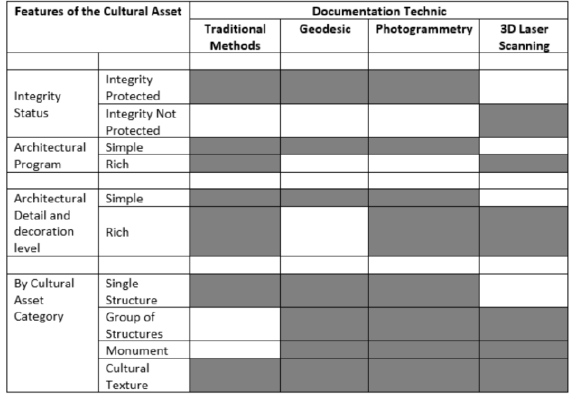
Table 1. Documentation Techniques Depending on